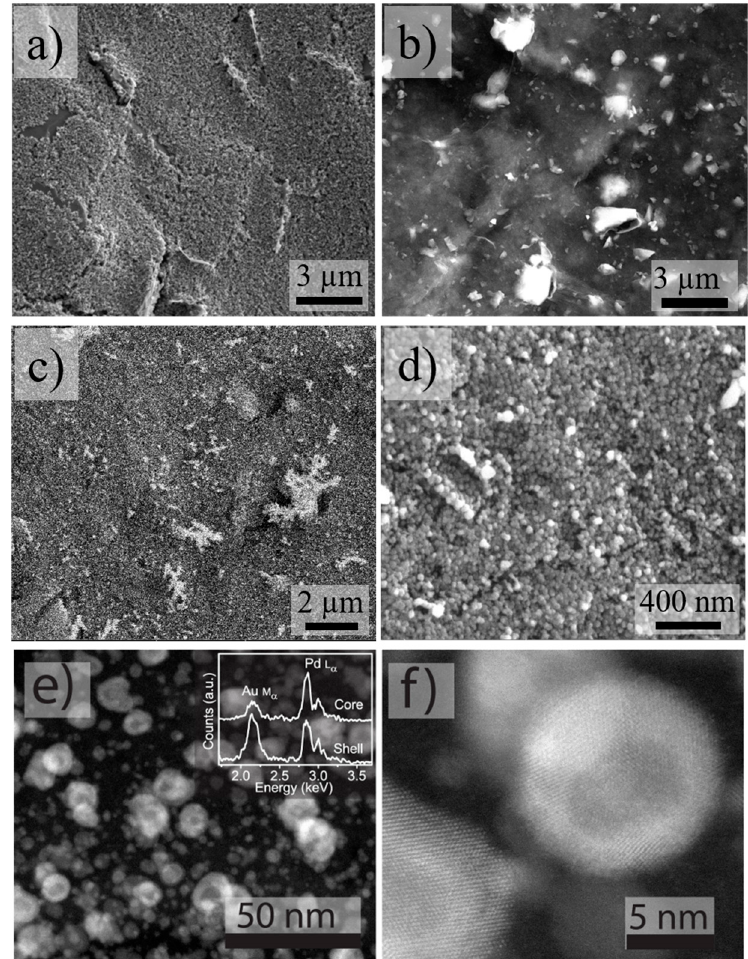
Figure 2. SEM ( a – d ) and TEM images ( e , f ) of the electrode revealing details of the fabrication steps. ( a ) Conventional SPE electrode. ( b ) SPE modified with rGO. ( c ) and ( d ) the electrode with core-shell gold–palladium nanoparticles. ( e ) STEM image showing the core-shell gold–palladium nanoparticles. The EDS elemental analysis is shown in the inset. ( f ) Details of the core-shell nanoparticles using high-resolution STEM